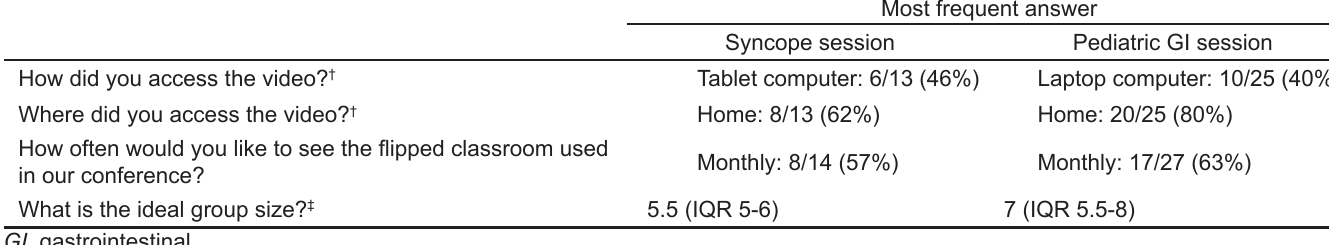
Table 1b . Tabulated responses of residents to flipped classroom survey.